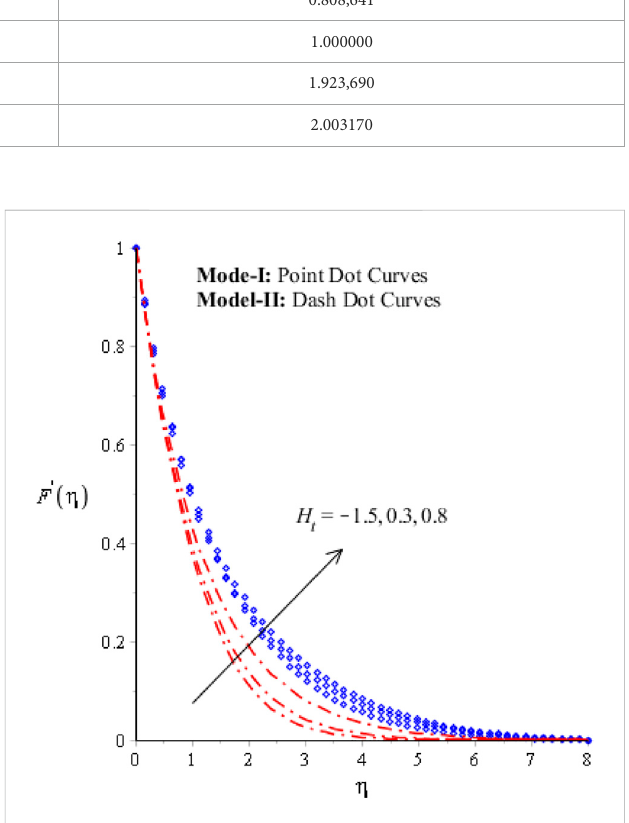
FIGURE 3 Effect of H t on velocity curves when α (cid:2) 0 . 3 , n (cid:2) 0 . 2 , Re (cid:2) 3 . 0 , We (cid:2) 2 . 0 , γ (cid:2) 0 . 2 , β (cid:2) 1 . 7 , Λ (cid:2) 0 . 3 , Pr (cid:2) 3 , ϵ (cid:2) 0 . 4 , Sc (cid:2) 0 . 4 , λ (cid:2) 0 . 4